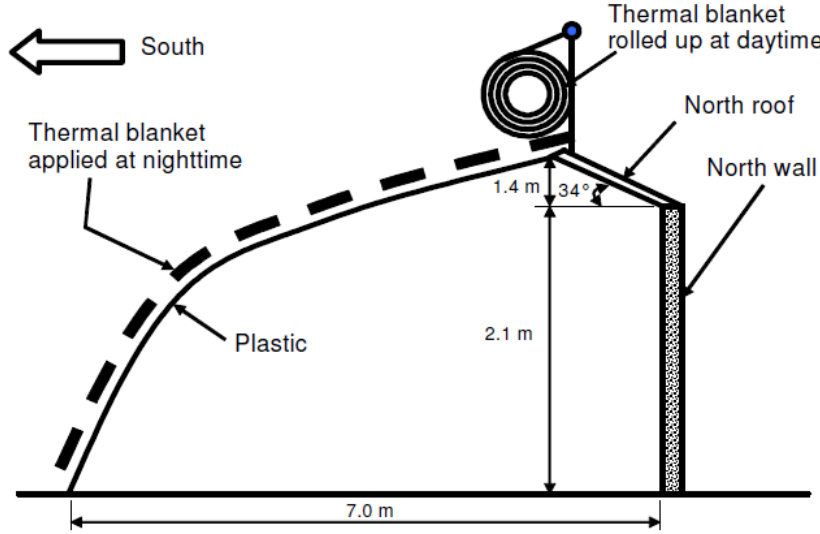
Figure 5. The side view of the study greenhouse used for validation of the model [7]. Table 1. Thermal properties of wall and north roof materials from exterior to interior layers.